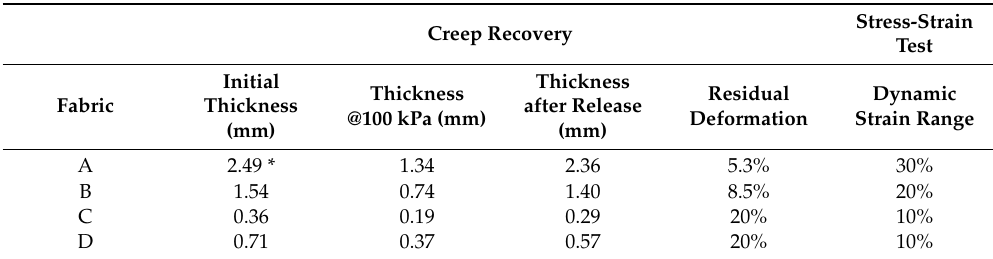
Figure 3. Mechanical characterization of the 4 di ff erent tested fabrics under creep recovery test: the arrow indicates the applied pressure (100 kPa for 1 min); the recovery time is 3 min. Table 1. Summary of main parameters extracted from mechanical